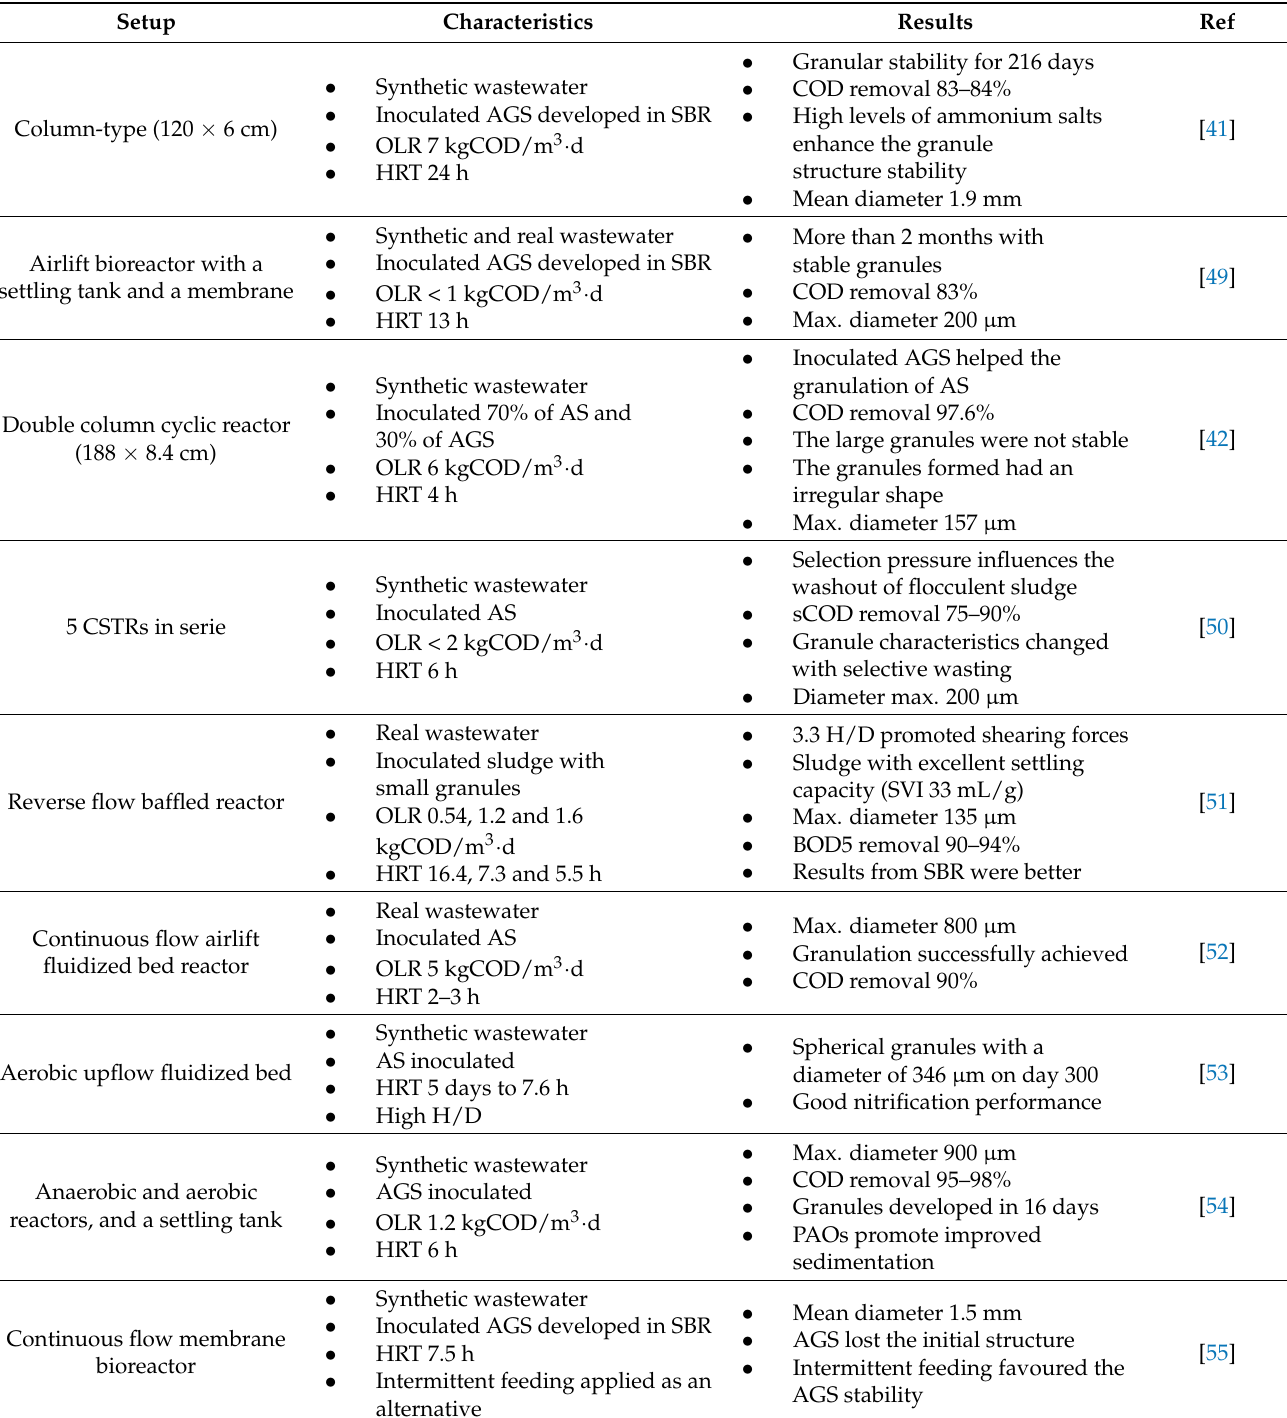
Table 1. Summarized AGS approaches in continuous flow